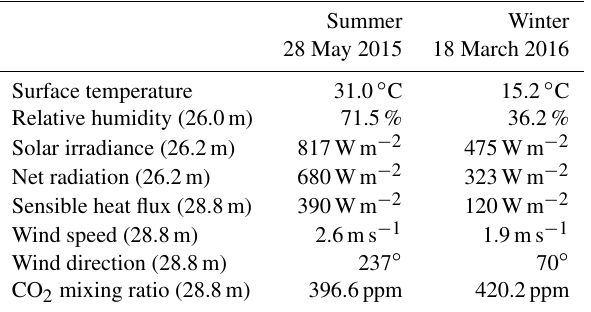
Table 1. Summary of weather conditions during the two campaigns (from 09:00 to 13:00PST) measured on top of the urban climate tower “Vancouver-Sunset” (Ca-VSu) located within the study tran- sect. Summer Winter Surface temperature 31.0 ◦ C 15.2 ◦ C Relative humidity (26.0m) 71.5% 36.2% Solar irradiance (26.2m) 817Wm − 2